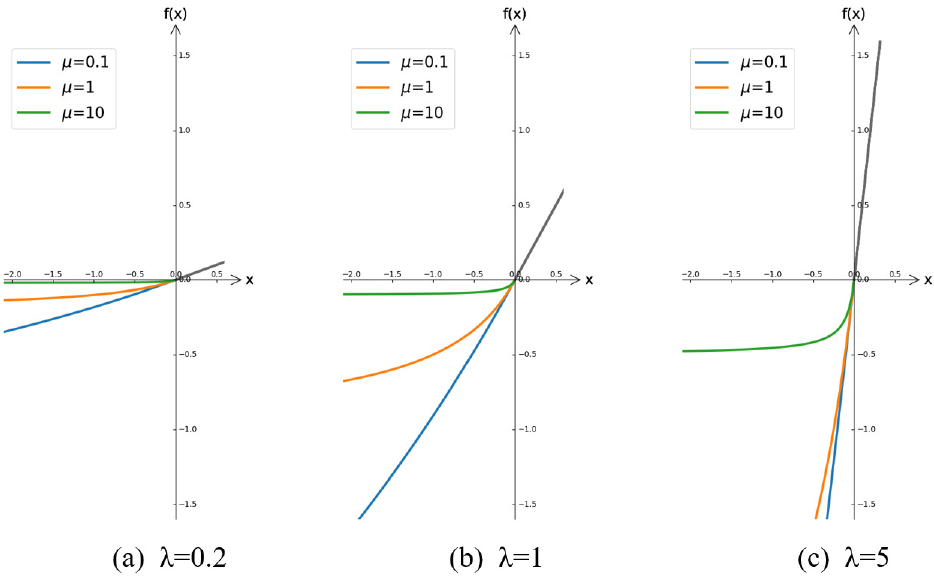
Figure 3. Different shapes of PFPLUS when λ and µ